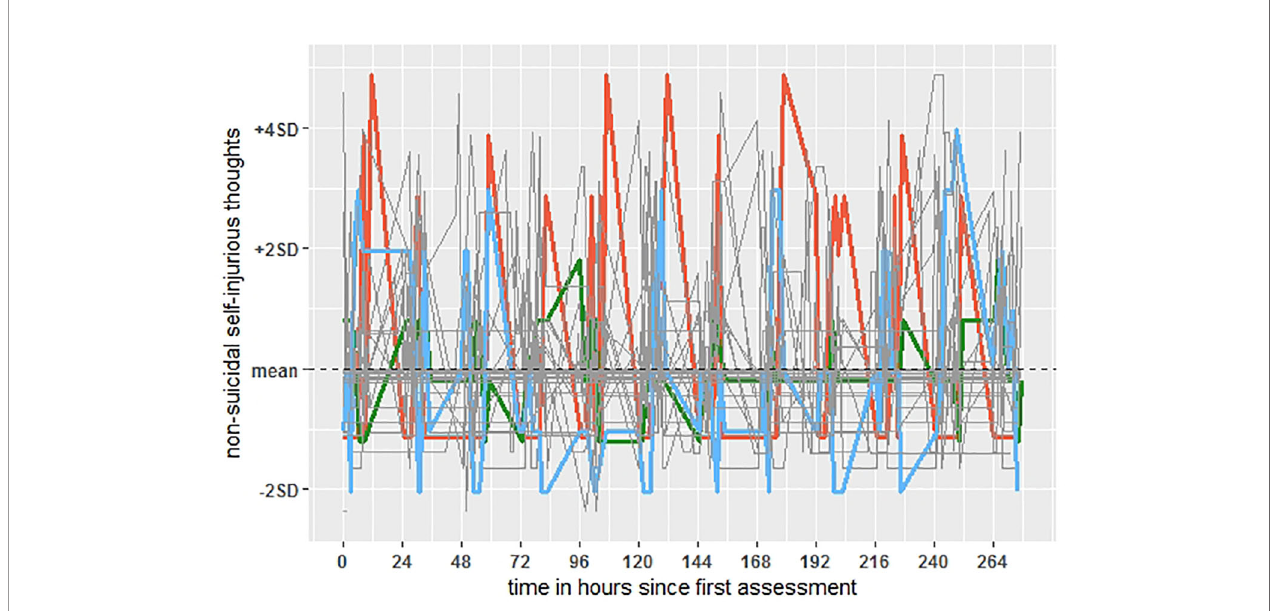
FIGURE 3 | Times series plot of non-suicidal self-injurious thoughts during the 12-day assessment period. Values are person-mean centered (comparing each's participant's hourly level of non-suicidal self-injurious thoughts to that individual's overall average across time; dashed line). The colored lines represent three randomly selected participants to illustrate within-person variability on an hourly basis.